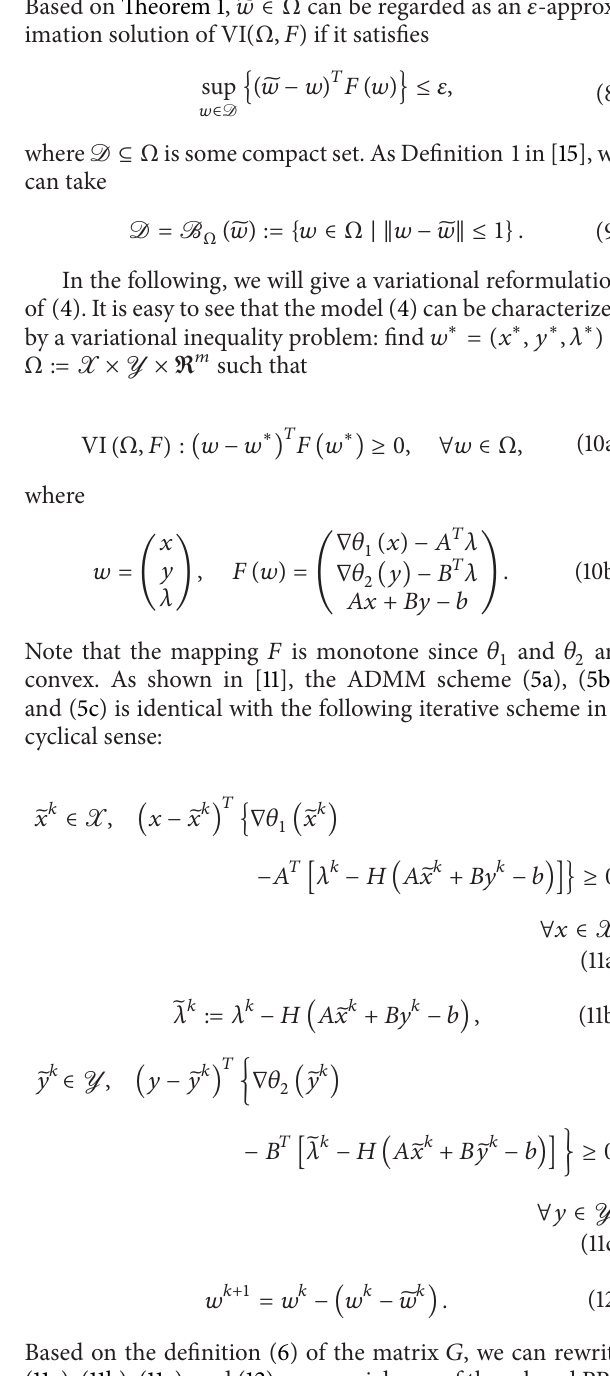
𝜃 R 𝑛 2 → R are convex smooth functions. The iterative 2 : scheme of ADMM for solving (4) at the 𝑘 -th iteration runs